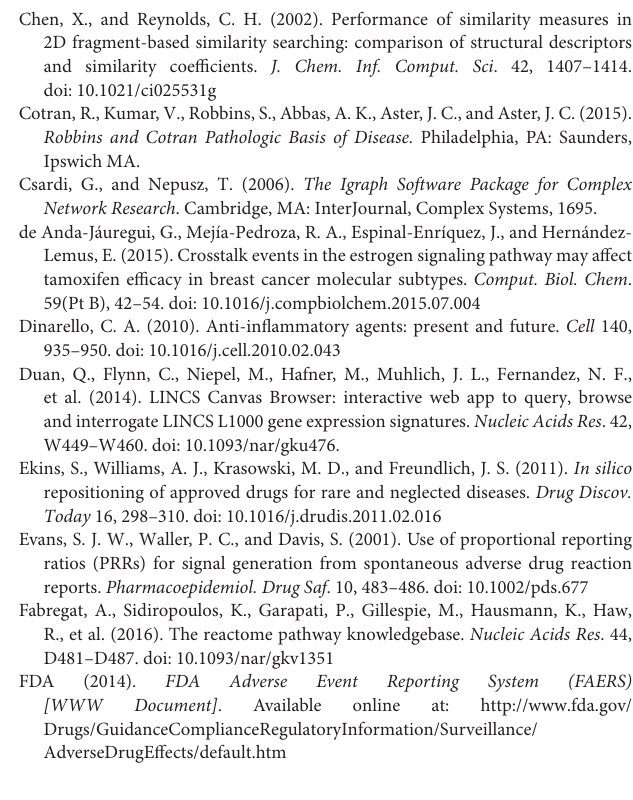
Supplementary Figure 3 | Redundancy coefficient in drug-pathway networks. (A) Drug nodes in the CMap-based network, (B) pathway nodes in the CMap-based network, (C) drug nodes in the LINCS-based network, and (D) pathway nodes in the LINCS-based network. In each panel, the normalized, cumulative redundancy frequency distribution is presented. Supplementary Figure 4 | Graph visualization of the drug-adverse drug reaction (ADR) network. A hive plot representation of the drug-ADR network is shown. This network comprises 52 drug nodes and 1,227 ADR nodes, with 9,597 links between them. Drugs nodes are arranged along the blue axis, while ADR nodes are arranged along the red axis. Edges between them are shown as Bezier curves. The transparency of each line is proportional to the edge strength. The network comprises a single large connected component containing all drugs and pathways. Supplementary Figure 5 | Clustering coefficient in drug-adverse drug reaction (ADR) networks. This figure illustrates the clustering coefficient distribution of (A) drug nodes and (B) ADR nodes. In each panel, the normalized, cumulative clustering coefficient frequency distribution is presented. Drug nodes have a maximum value of 0.18, while pathway nodes have a maximum value of 0.24. Supplementary Figure 6 | Redundancy coefficient in drug-adverse drug reaction (ADR) networks. This figure illustrates the redundancy coefficient distribution of drug nodes (A) drug nodes and (B) ADR nodes. In each panel, the normalized, cumulative redundancy frequency distribution is presented for drug and ADR nodes, respectively. Supplementary Figure 7 | Node strength in drug-adverse drug reaction (ADR) networks for drug nodes. The normalized, cumulative strength distribution for drug nodes is shown, with a range of 0 to 85,591.61. A node’s strength in a weighted network is the sum of the weights of all adjacent edges. In this network, an edge weight represents the risk of an ADR for a given drug. Therefore, a drug’s node strength is a measure of general risk for a